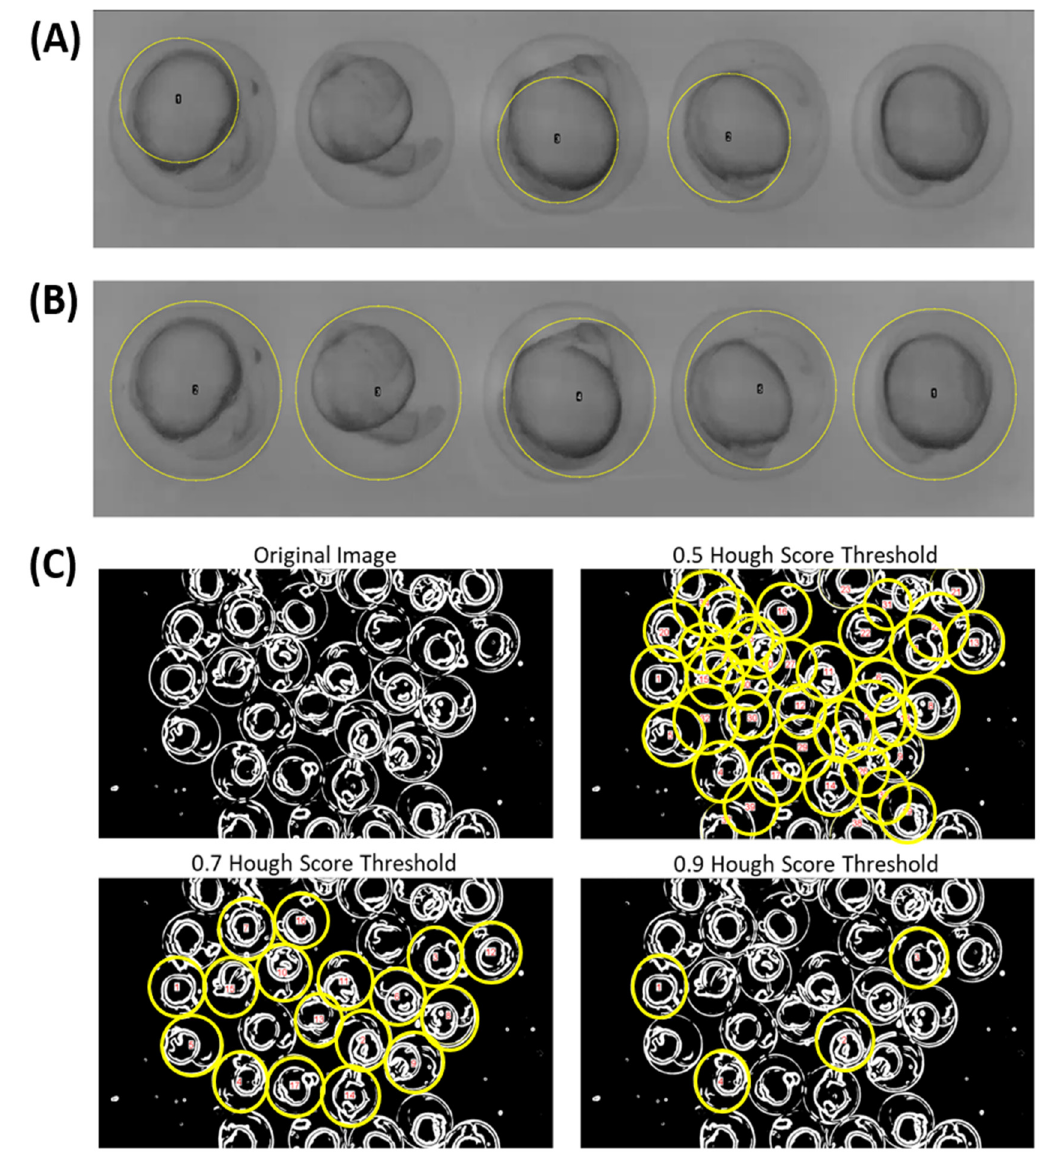
Figure 2. Optimization of Hough Circle Transformation for object circularity detection. Hough Circle Transform result according to ( A ) Zhang et al., 2019 method or ( B ) our proposed TCMacro method (Hough Score Threshold = 0.5). ( C ) Hough Score Threshold value fine-tuning to acquire the best automatic ROI selection result. Recorded at 12 × magnification. Eggs be correctly selected were labeled with yellow circles.